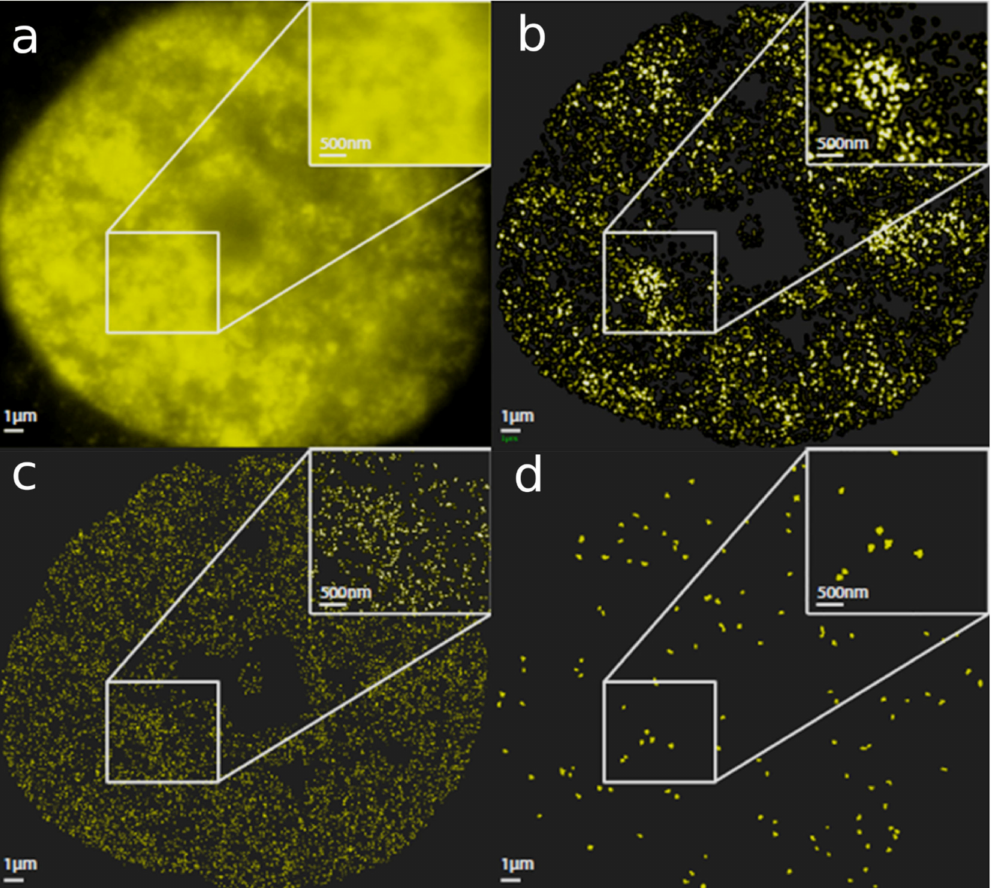
Figure 2. Resolution of the heterochromatin network reconstructed from loci data of fluorescent molecules of an H3K9me3- stained breast cancer SKBr3 nucleus in a localization microscope. The images of an SkBr3 (breast cancer cell line) cell nucleus show: ( a ) A fluorescence wide-field image after heterochromatin staining with specific antibodies against H3K9me3 methylation sites. The inset shows a magnification of a region around small alveoli. ( b ) The same cell nucleus reconstructed from the localization data of the single fluorescence molecules as a density map. This means that point intensity relates to the number of neighbors. Due to soft focus filters, details of molecular arrangements are lost, but high (knots) and low (alveoli) density structures can be easily detected. Such image reconstructions based on density histograms are similar to conventional microscope images and allow a comparison to other techniques in many cases. The insert indicates that the shapes obtained by standard microscopy can be resolved into heterochromatin arrangements of different shape and molecular density. ( c ) Full pointillist localization image of all fluorescent molecules detecting H3K9me3 sites. Such images are obtained from data sets that are the basis for all quantitative structure and topology analyses using mathematical algorithms of statistics, geometry, and topology. The inset qualitatively indicates that the high-density knots revealed a structured folding. ( d ) Cluster image as a result of mathematical operations on the localization data set (visualized in ( c )). The image only shows the areas that met a certain cluster parameter. The insert indicates that the dense heterochromatin regions consisted of clusters embedded in heterochromatin structures shown in ( c